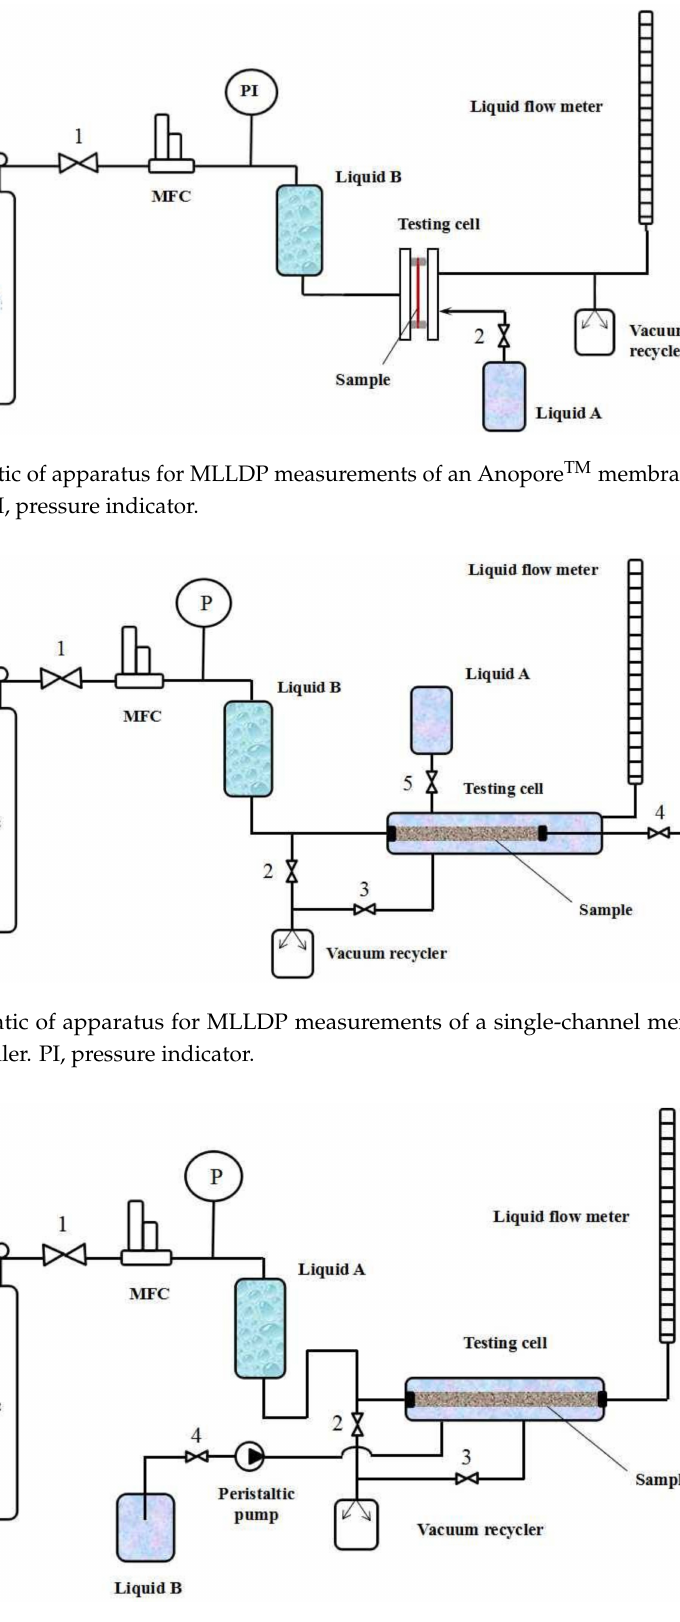
Figure 5. Schematic of apparatus for MLLDP measurements of a multichannel membrane. MFC, mass flow controller. PI, pressure